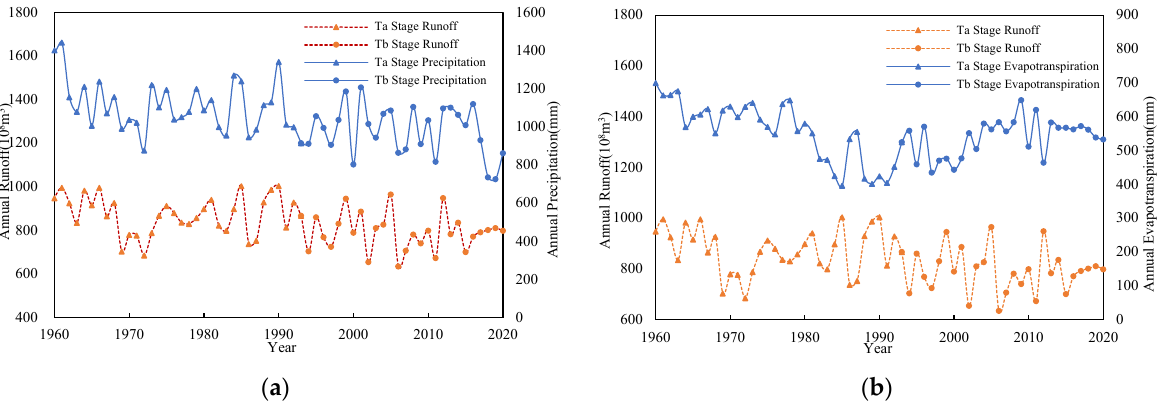
Figure 4. ( a ) Trend chart of the annual runoff and the annual precipitation in the Min River basin before and after the sudden alteration; ( b ) trend chart of the annual runoff and the annual evapotranspiration in the Min River basin before and after the sudden alteration.